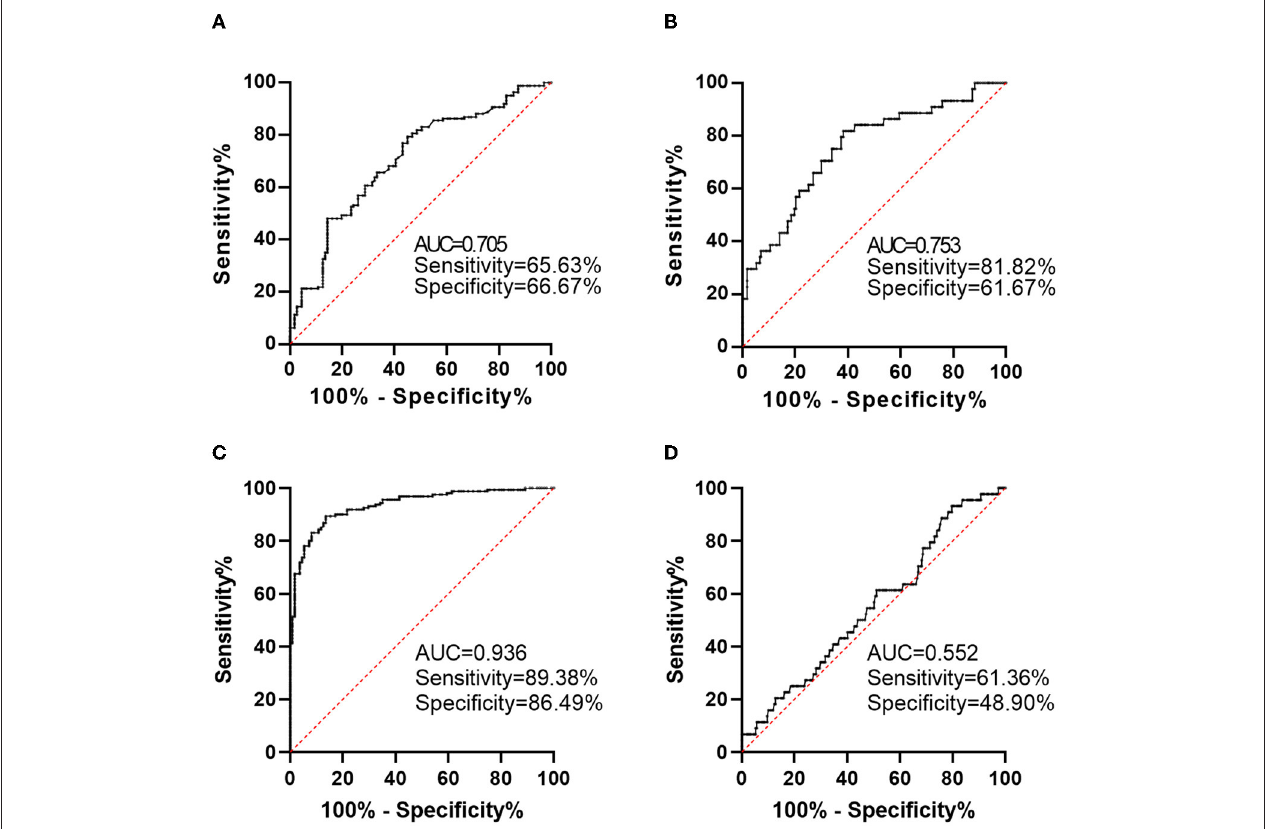
FIGURE 3 | Predictive value of calprotectin for short-term functional outcomes of AIS. (A) Predictive value of calprotectin for poor outcome 2 weeks after AIS onset as reflected by mRS ≥ 3. (B) Predictive value of calprotectin for disease progression during a 2-week follow-up as reflected by an increase in NIHSS score. (C) Predictive value of the combination of calprotectin, infarction volume, and NIHSS at admission for poor outcome 2 weeks after AIS onset. (D) Predictive value of the combination of calprotectin, infarction volume and NIHSS at admission for disease progression during a 2-week follow-up.